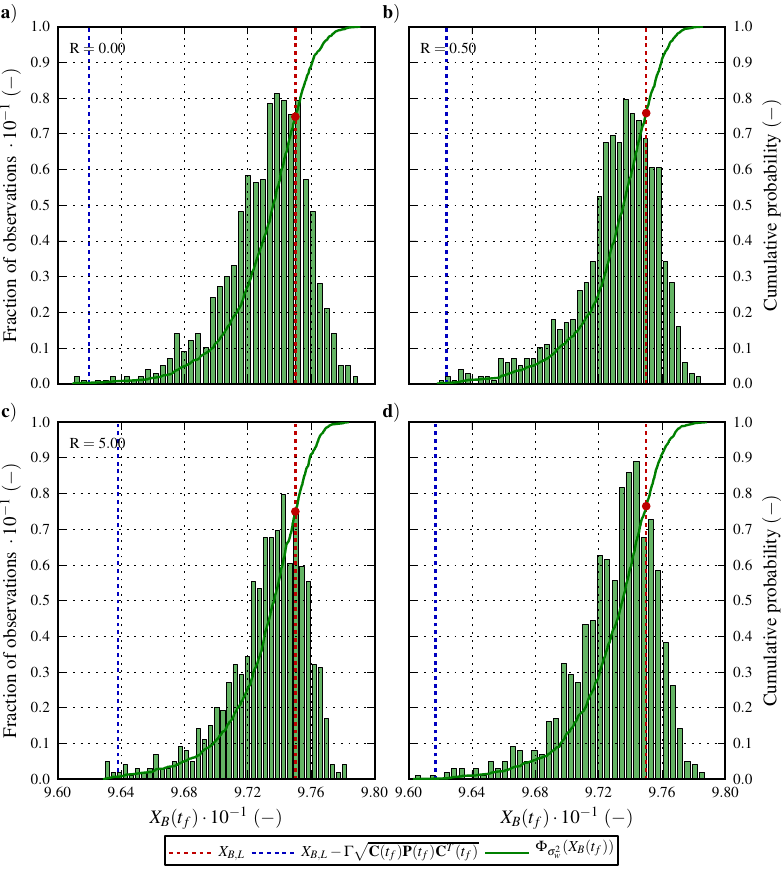
Figure 9. Probability distribution of the variability in X B ( t f ) generated with the set of stochastic control signals, ˜ u , sampled from a uniform distribution with the uncertainty level σ = 5 . 0%. The dashed lines indicate the lower purity constraint, X w C ( t ) P ( t ) C T ( t ) . The solid line indicates the cumulative worst-case purity, X B , L Γ f f f − ( X ( t )) probability, Φ B f σ 2 (cid:112) w